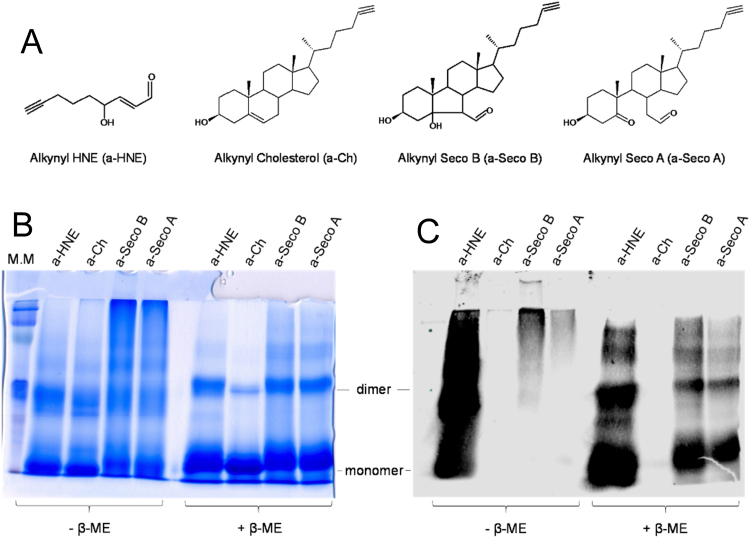
Analysis of apo-SOD1 adduction to alkynyl analogues of HNE or secosterol aldehydes by click chemistry. (A) ω-alkynyl lipid structures: alkynyl cholesterol (a-Ch); alkynyl Seco B (a-Seco B); and alkynyl Seco A (a-Seco A). (B) SDS-PAGE of the apo-SOD1 WT (10 μM) incubated with alkynyl-lipids (250 μM) analyzed under non-reducing (-β-ME) and reducing conditions (+β-ME) and stained with Coomassie-blue. a-Seco A and Seco B induced the formation of large aggregates, while a-HNE did not. (C) Detection of SOD1 adduction to alkynyl eletrophiles by click chemistry. SOD1 modified by alkynyl lipids were labeled with biotin and stained with streptavidin conjugated with the Alexa Fluor 680 fluorophore. Intensive staining was found for a-HNE, while for a-Seco A and a-Seco B, staining was concentrated in the large aggregate region.